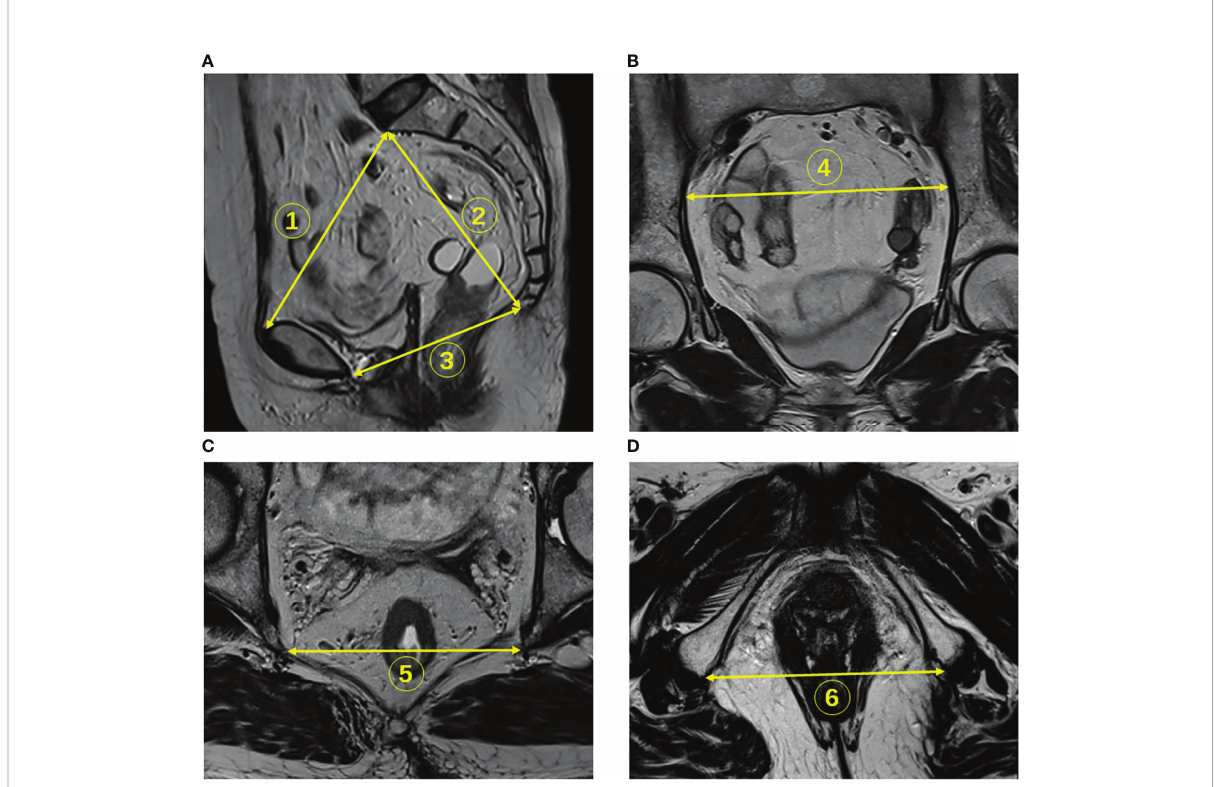
FIGURE 2 Identi fi cation of pelvimetry measurements on MR images. (A) The pelvic inlet (line 1), pelvic depth (line 2), and pelvic outlet (line 3) were measured on sagittal T2WI. (B) The transverse diameter was measured on coronal images (line 4). (C) The interspinous distance was measured on axial T2WI (line 5). (D) Intertuberous distance was measured on axial sections (line